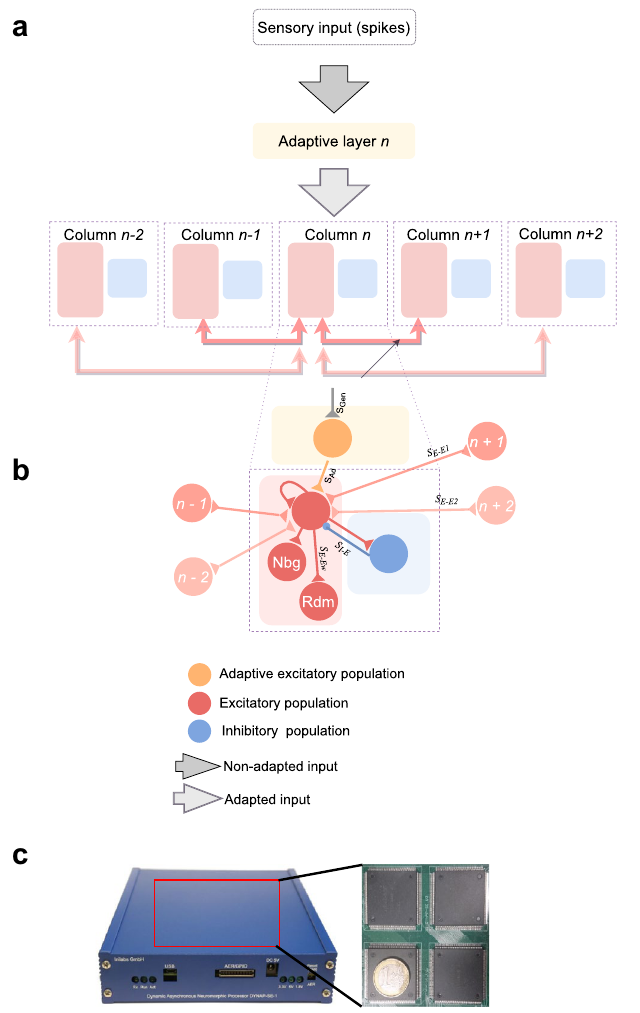
Figure 3. Network architecture (population and single neuron connectivity) and neuromorphic hardware used in this study. A network constituted of five cortical columns has been implemented using a recurrent neural network to represent the primary auditory cortex A1. (a) Arrows illustrate the connectivity of one column and the shades of the arrows the strength of its connections to the other columns (strength decreasing according to their distance to the column receiving the sensory input (S E − E 1 and S E − E 2 ). Spikes from the spikes generator are received by the adaptive layer (S Gen ). (b) Each column contains both excitatory (E) neurons and inhibitory (I) neurons with a ratio of 4/1 and receives adapted input spikes (S Ad ) from the adaptation layer which in return activates the whole column through the intracolumnal recurrent connections (S E − EW ) with random (Rdm) and neighbouring (Nbg) neurons. (c) The Dynamic Neuromorphic Asynchronous Processor Scalable (DYNAP-SE) board is composed by four chips comprising each four cores and each of the core possess 256 adaptive exponential integrate-and-fire neurons. The figure represents the external appearance of the neuromorphic processor (blue box) and the printed circuit board of the four chips. Neurons and synapses parameters can be programmed via an on-chip bias